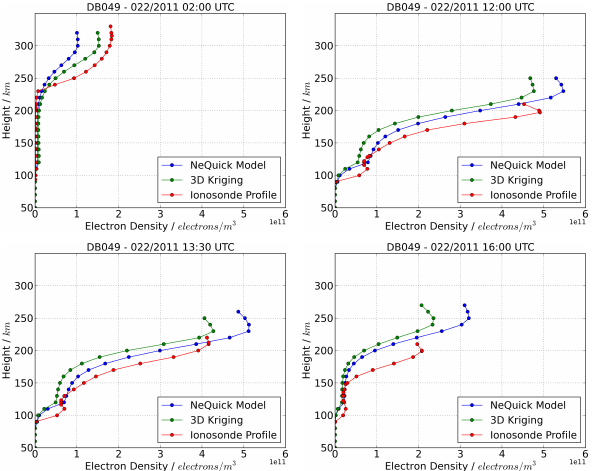
Figure 7. Comparison of the NeQuick model (blue), the recon- structed (green) and the ionosonde (red) F2 layer peak character- istics at the ionosonde station locations of DB049 (left column) and RO041 (right column) on DOY 22